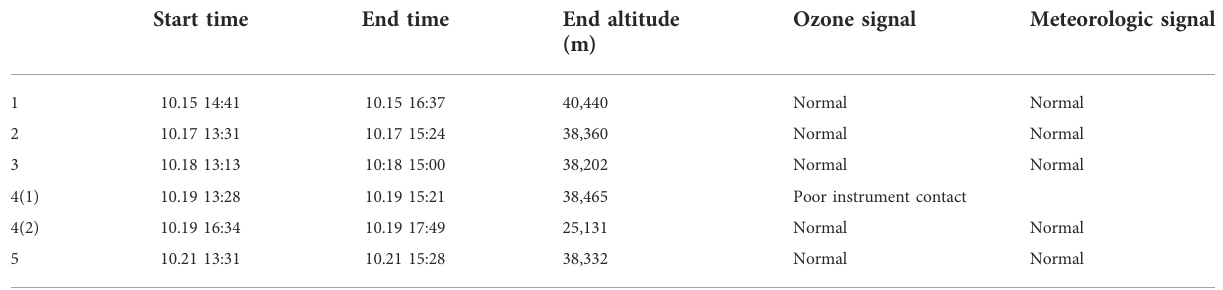
TABLE 1 Information of sounding data collected over Shanghai from October 15 to 21 October